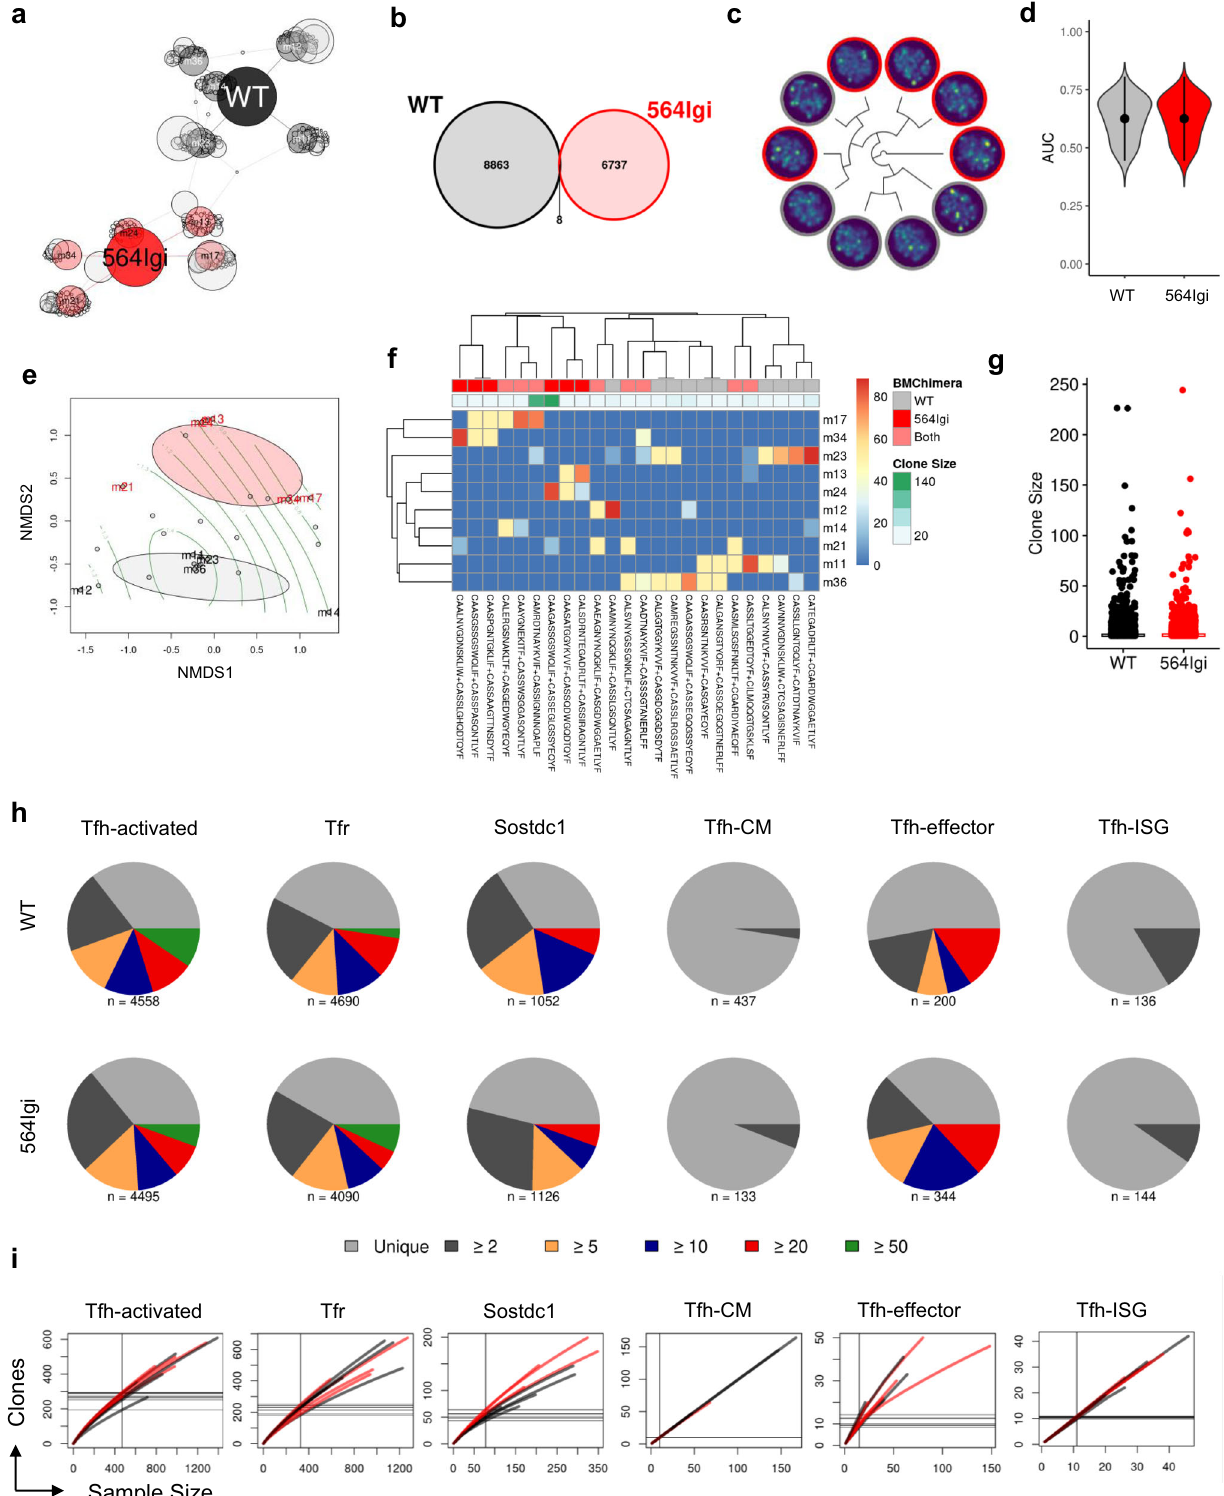
speci fi city groups (absolute log 2 FC < 2.5) were often polyclonal with limited clonotype sharing amongst speci fi city groups. In contrast, condition-speci fi c speci fi city (absolute log 2 FC > 2.5) groups were pauciclonal, sharing clonotypes with public speci fi - city groups but not with each other (Fig. 5b, e). These fi ndings suggest that non-shared speci fi city groups represent